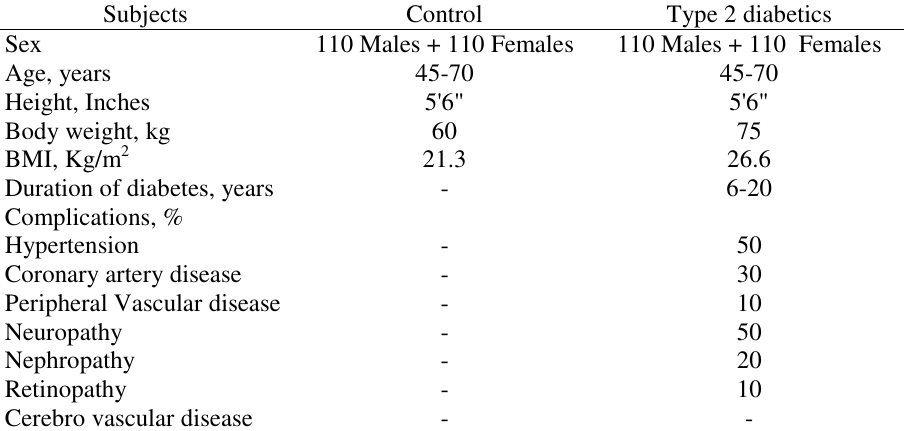
Table 1. Case history of the chronic type 2 diabetic subjects